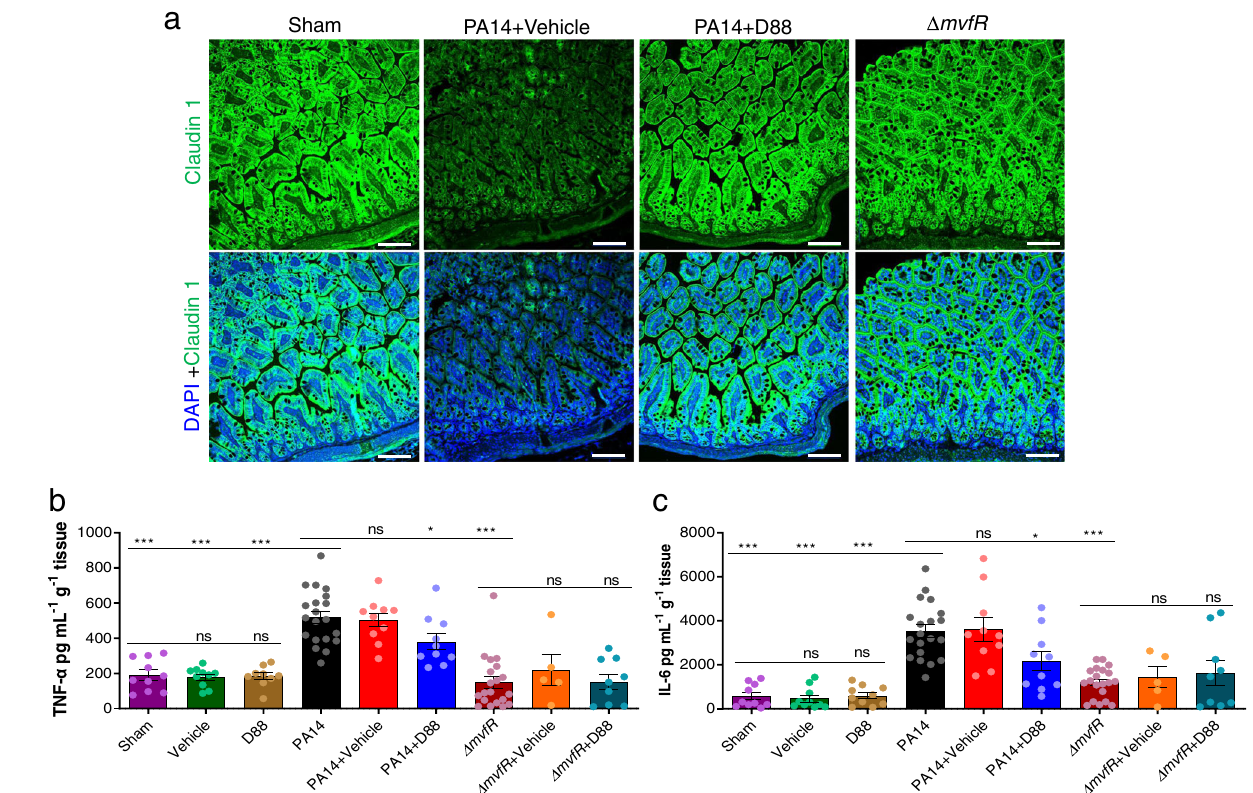
Fig. 7 | D88 mitigates the morphologic alterations of the intestinal lining and attenuates intestinal in fl ammation. a Representative confocal image ( n =2) of distal ileum with Claudin-1 immuno fl uorescence staining. The experiment was repeated independently two times with similar results. Samples for confocal ima- ging were harvested 22h post-burn and infection. Green fl uorescence represents Claudin-1, and blue fl uorescence represents the DAPI stain, the white line repre- sentsthe scale bar(100 µ m). b Levelsof tumor necrosis factor (TNF- α ) inthe distal ileum 22h post-burn and infection. The total protein was isolated from the distal